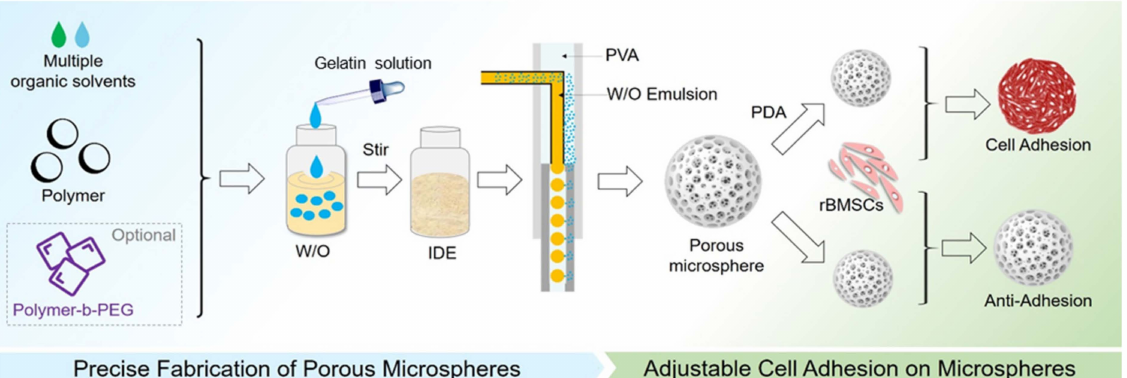
Figure 1. Schematic illustration of the preparation of iso-density emulsion (IDE), the fabrication of porous microsphere, and PDA modification for cell